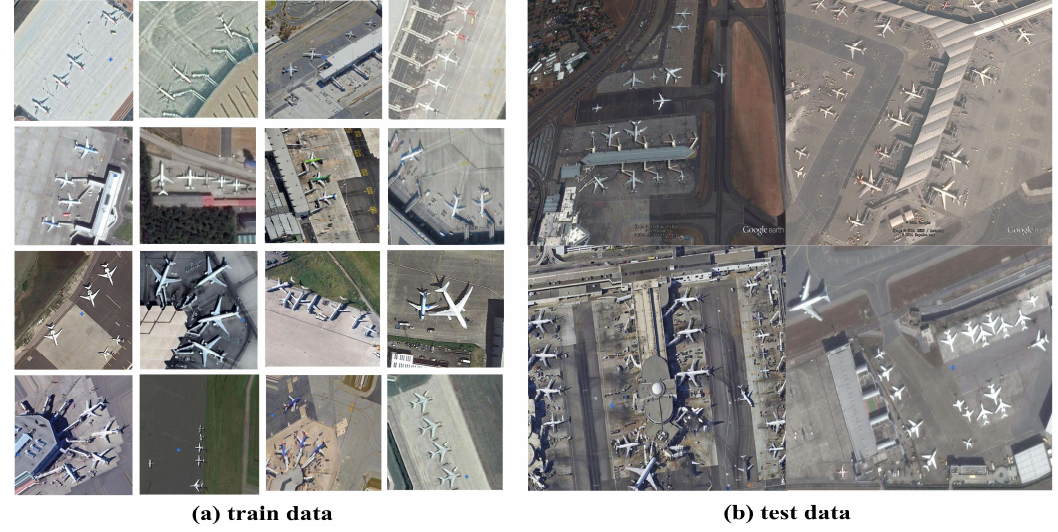
Figure 12. Examples of data.